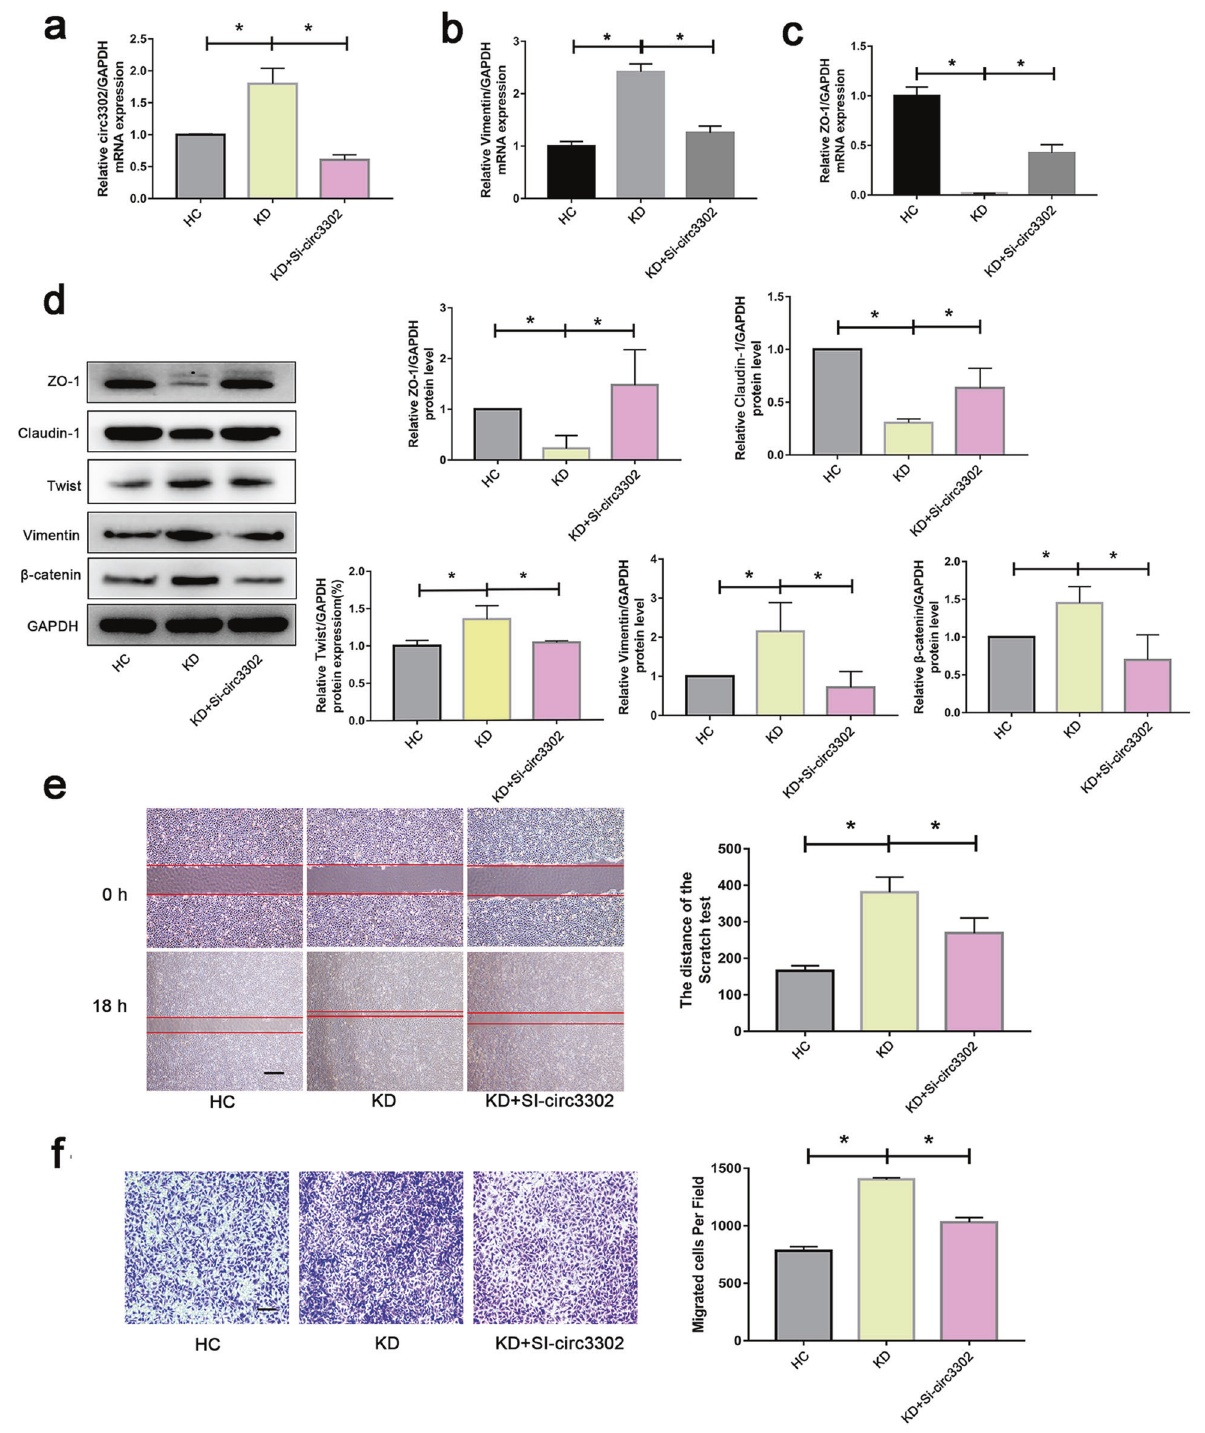
Fig. 4 Effect of circ3302 silencing on KD serum-induced EndoMT. a – c HUVECs were transfected with si-circ3302, and then treated with medium containing 15% sera from HC ( n = 6) and KD subjects ( n = 6) for 48 h. Next, the expression of circ3302, Vimentin and ZO-1 was measured by RT-qPCR analysis. d Endothelial cells were treated as above, and then the protein levels of ZO-1, Claudin-1, Twist, Vimentin, and β -catenin were measured by western blot analysis. e , f Effect of circ3302 silencing on KD serum-induced migration was evaluated using scratch and transwell assays. Magni fi cation:×40 and scale bar = 100 μ m for scratch assay. Magni fi cation:×100 and scale bar = 50 μ m for transwell assay. * P < 0.05 vs. the HC group or KD group.